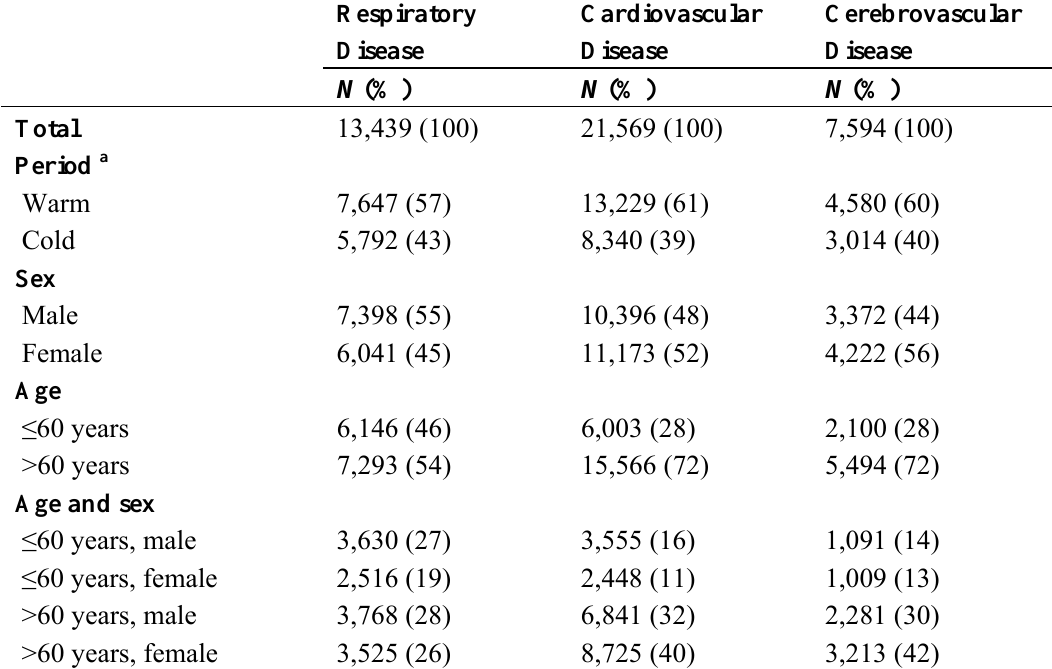
Table 1. Characteristics of cause-specific mortality in Cape Town, South Africa (1